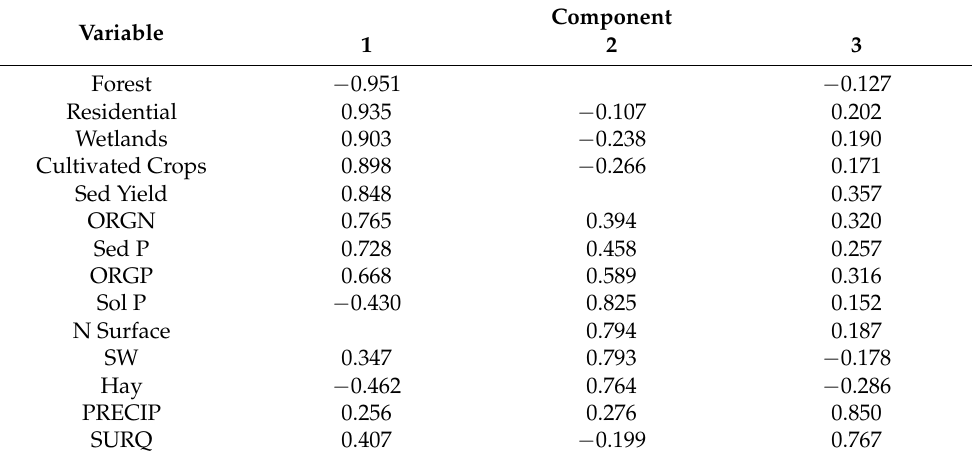
Table A10. Varimax-rotated